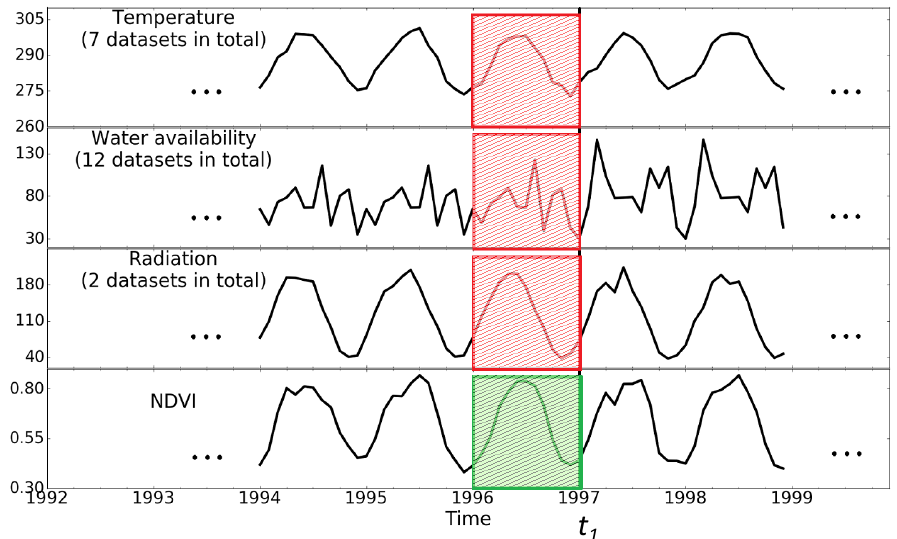
Figure 1. An illustrative example of the moving window approach considered in the analysis of vegetation drivers at a given timestamp t 1 . Here, NDVI takes the role of the time series y in Eq. (3). In addition, three climate predictor time series are shown. The baseline random forest model only considers the green moving window, whereas the full random forest model includes the red moving windows as well. The pixel corresponds to a location in North America (lat: 37.5 ◦ , long: − 87.5 ◦